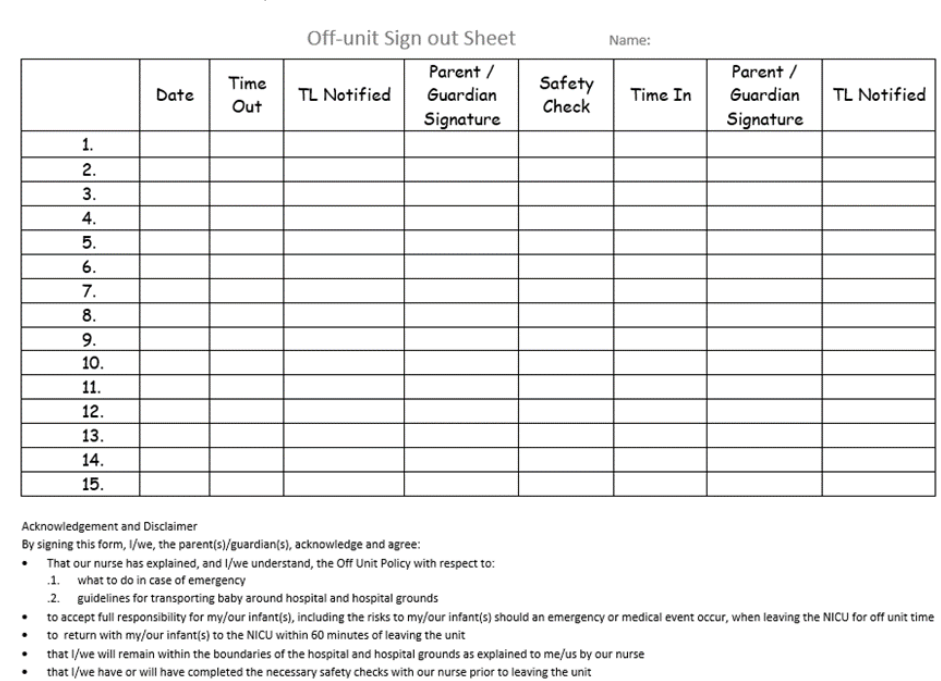
Figure A2. Off- Unit Sign out Sheet. Figure A2. Off-Unit Sign out